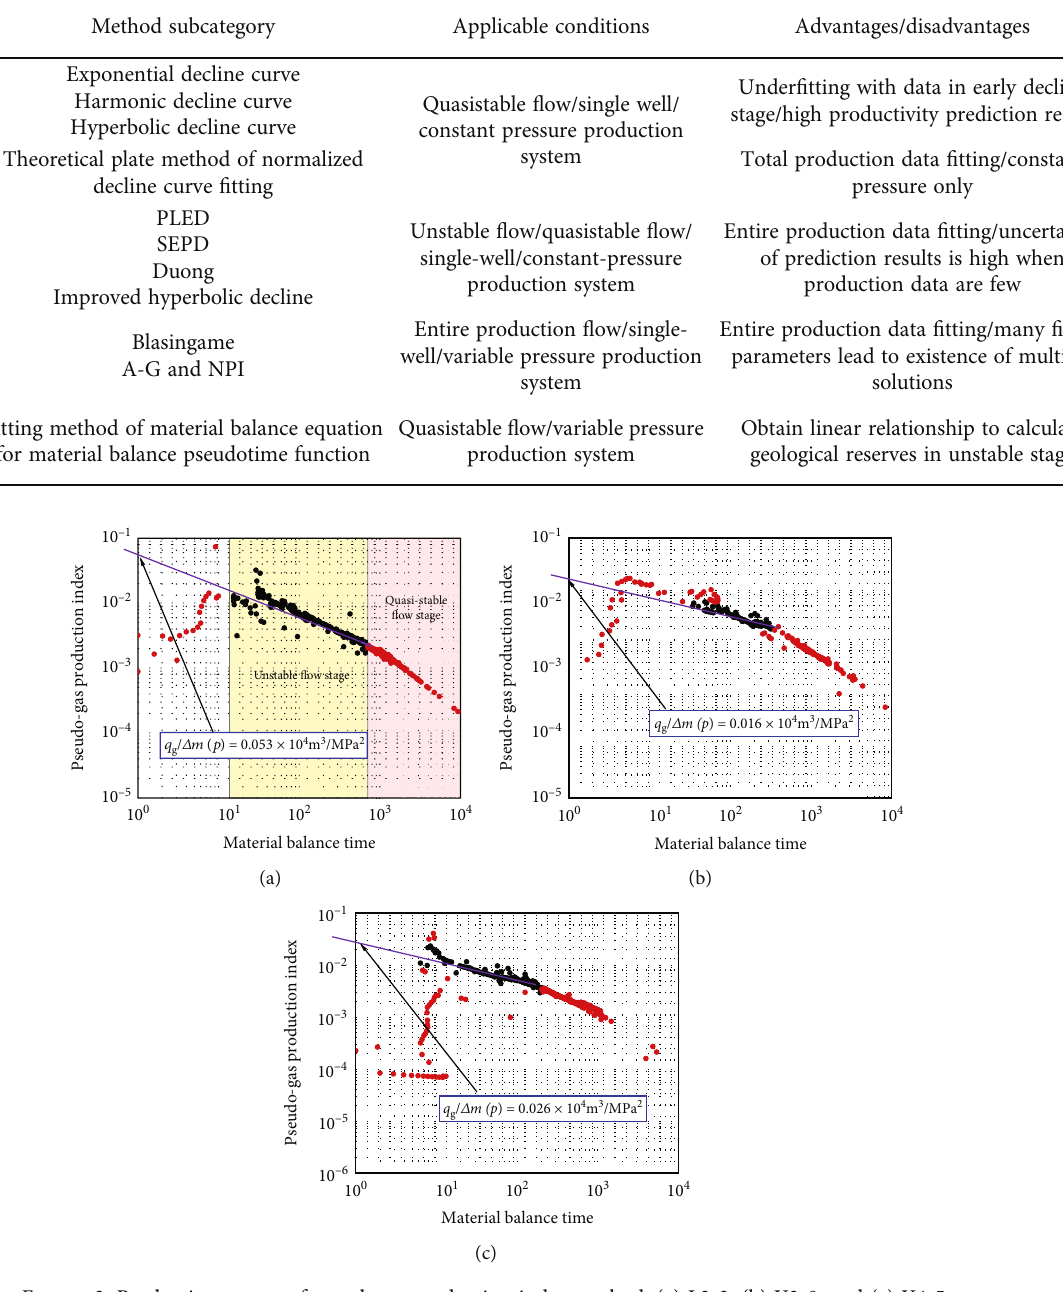
Figure 3: Production curves of pseudogas production index method: (a) L2-3, (b) Y2-8, and (c) Y4-5. Table 2: Calculation parameters and results of pseudogas production index